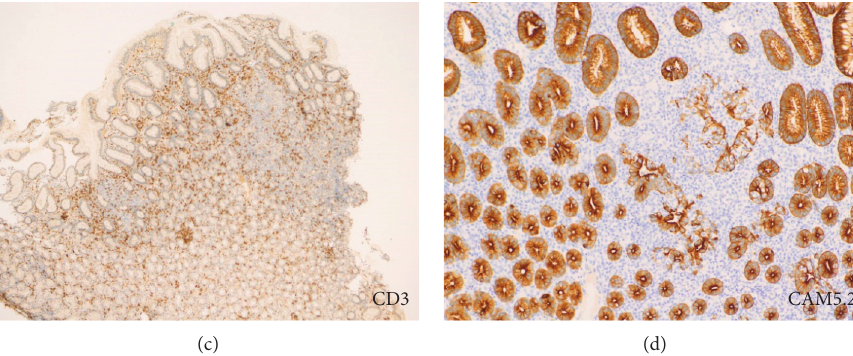
Figure 2: Images of the pathologic analysis of the gastric lesion. Small to medium sized lymphoid cells are observed in the biopsy specimens (a). These cells are positive for CD20 (b) and negative for CD3 (c). Immunostaining for cytokeratin (CAM5.2) shows the formation of lymphoepithelial lesions (d). Gastric MALT lymphoma was diagnosed.